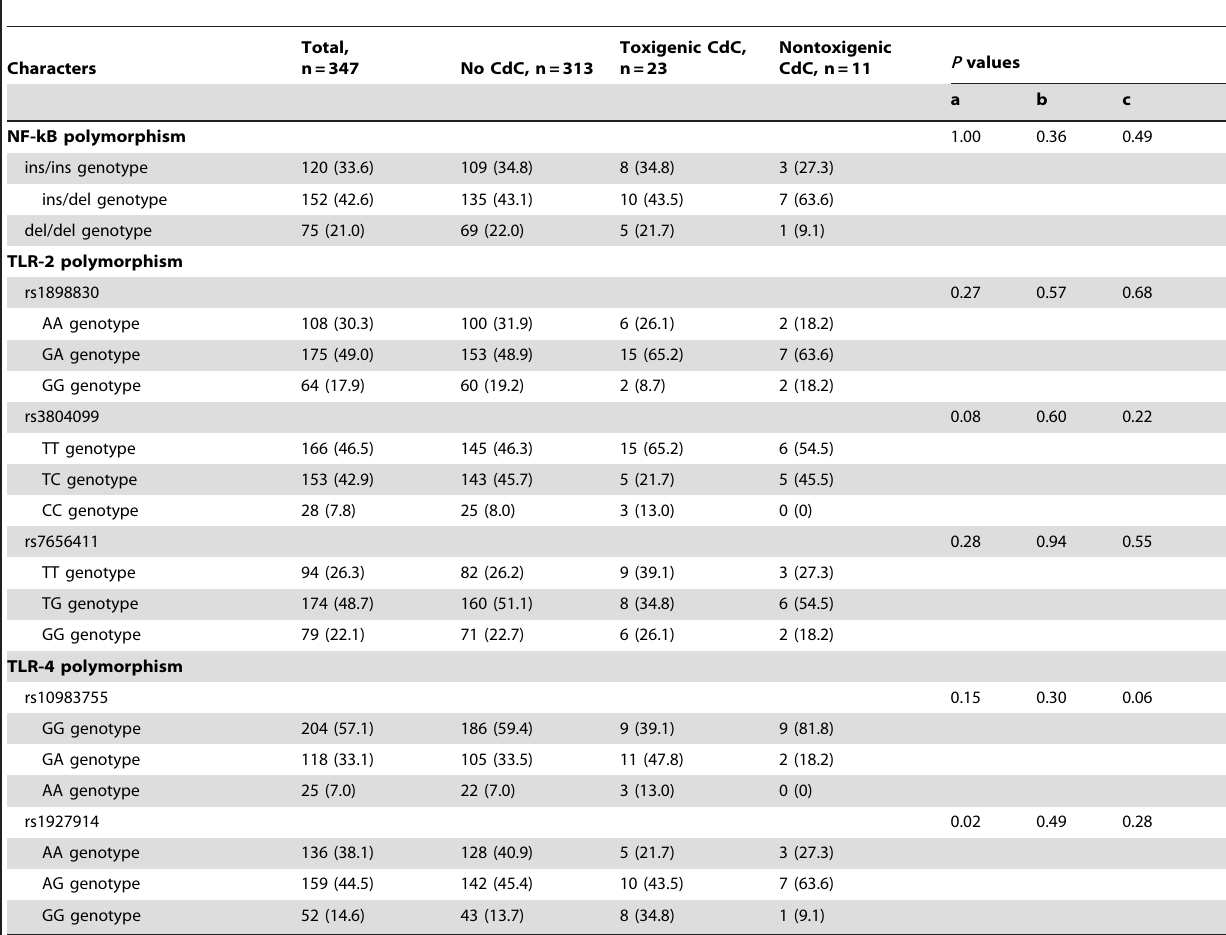
Table 2. Correlation of fecal Clostridium difficile colonization (CdC) at admission among 347 patients with NF-kB, TLR-2 or TLR-4